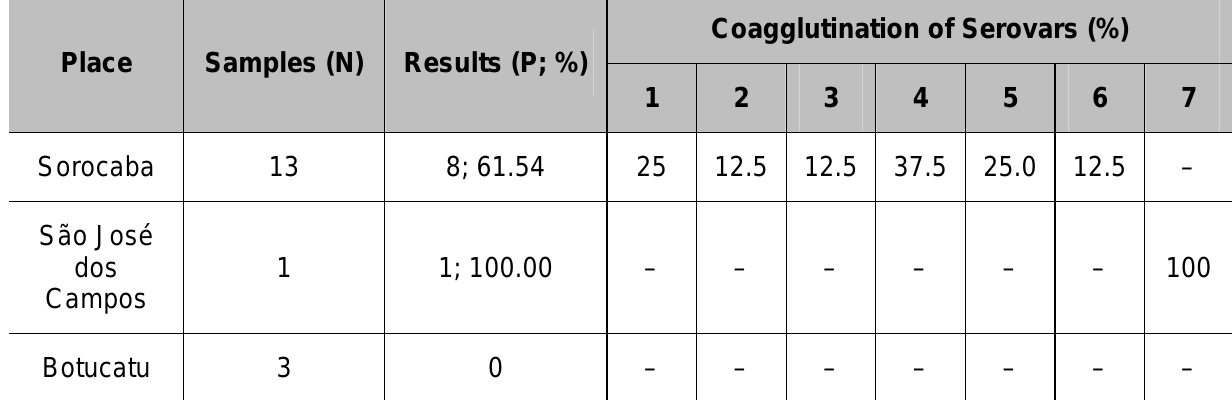
Table 2. MAT seropositivity for Leptospira spp. antibodies in captive coati serum samples and percentage of